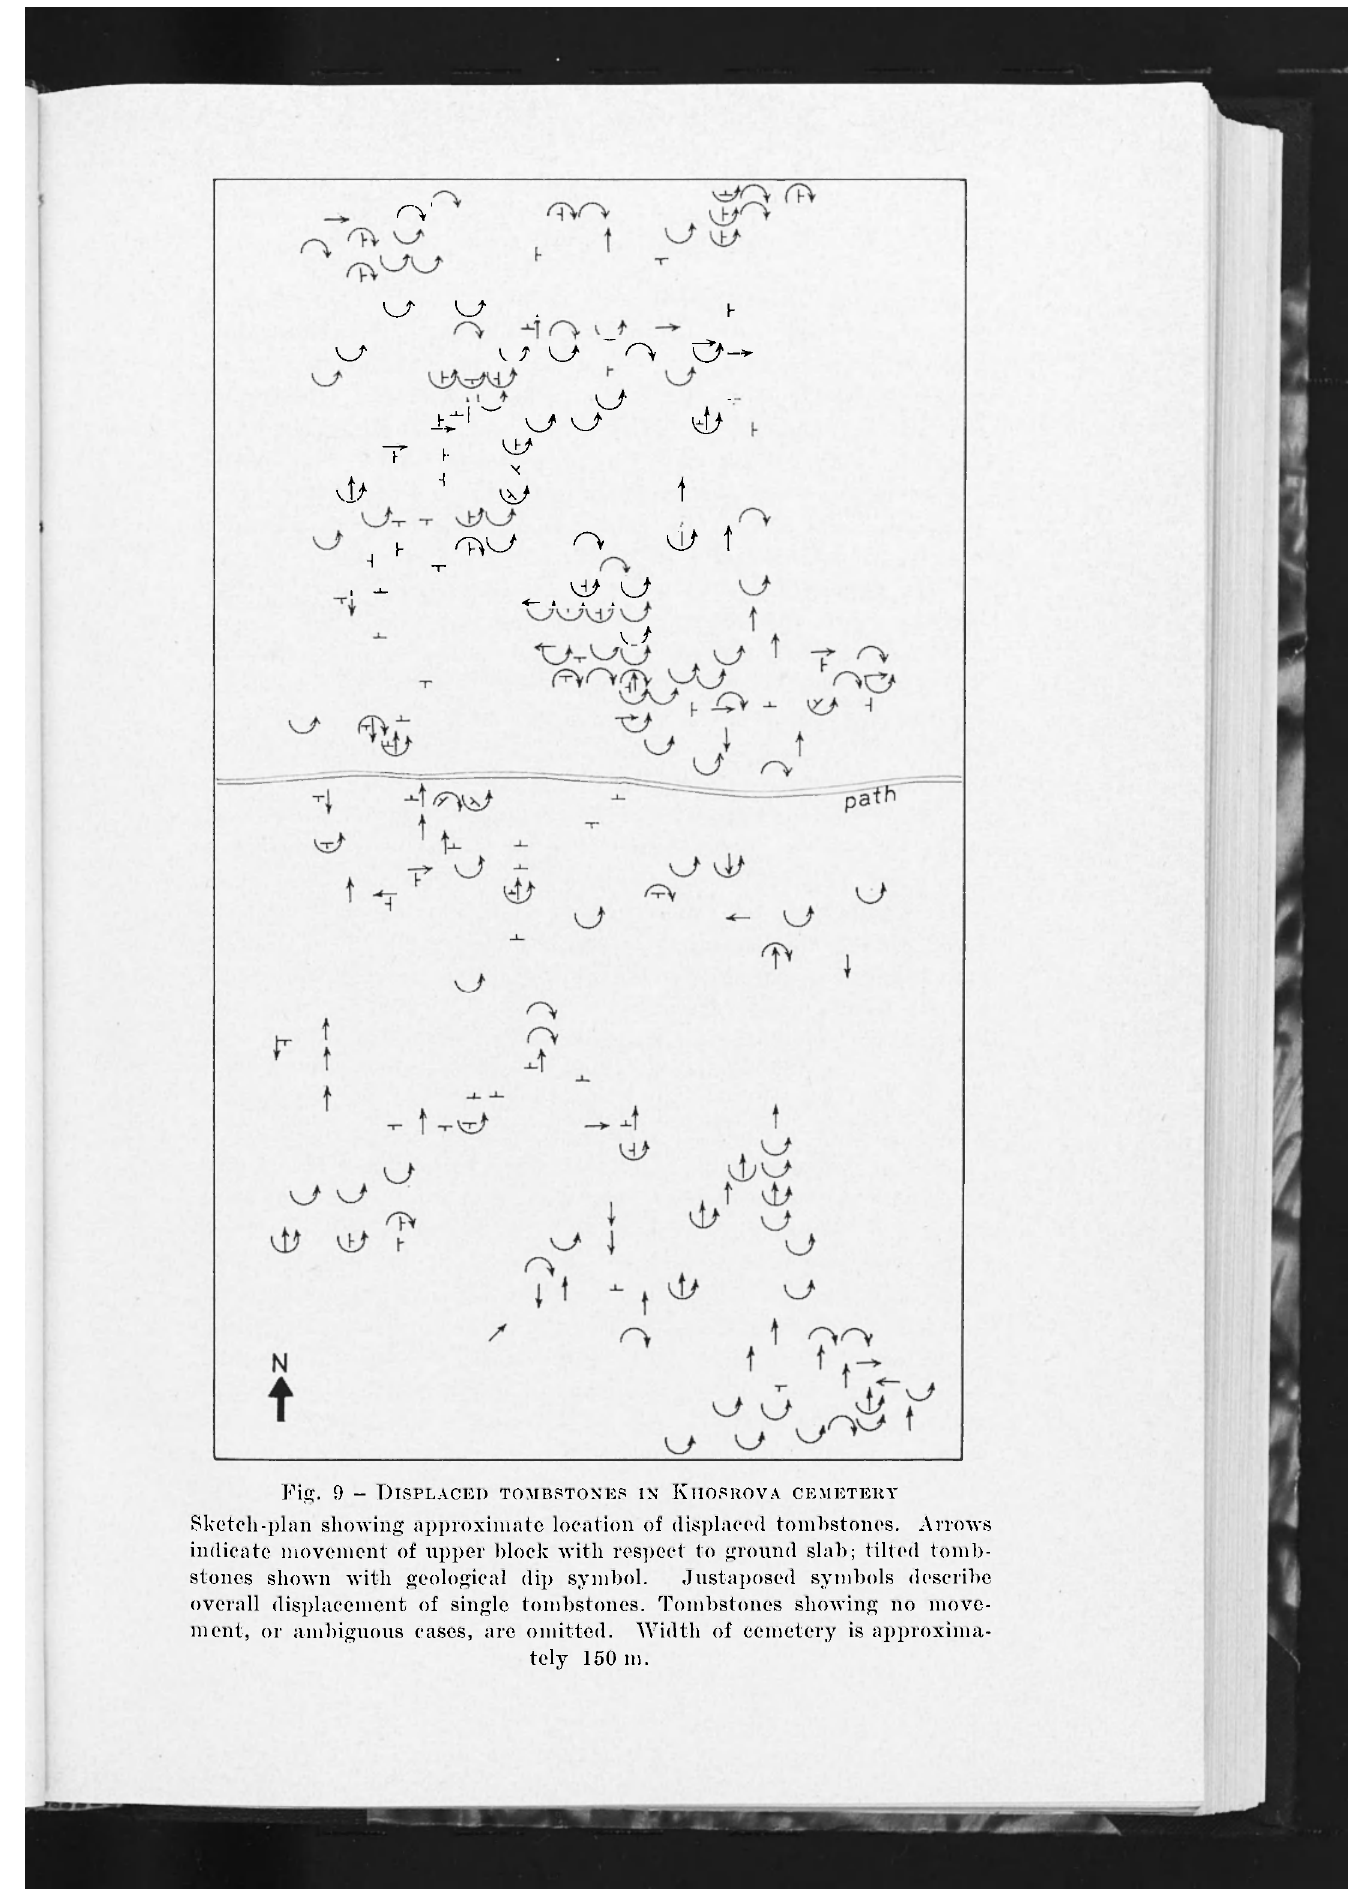
Fig. 9 - DISPLACED TOMBSTONES IN KIIOSROVA CEMETERY Sketch-plan showing approximate location of displaced tombstones. Arrows indicate movement of upper block with respect to ground slab; tilted tomb- stones shown with geological dip symbol. Justaposed symbols describe overall displacement of single tombstones. Tombstones showing no move- ment, or ambiguous cases, are